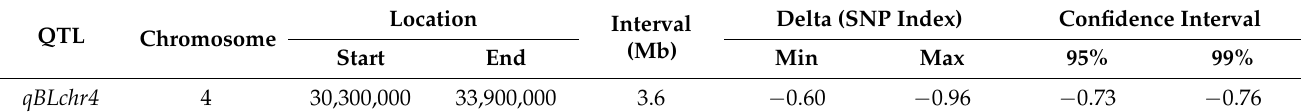
Table 3. QTL detected for blast resistance in PLD.